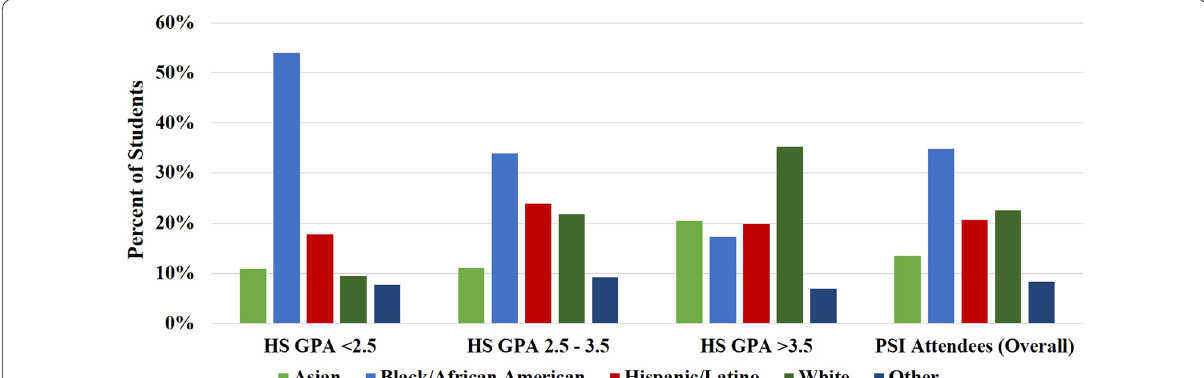
Fig. 7 Self‑identified racial/ethnic demographic distribution of students attending PSI sessions, separated by HS GPA, and compared to the self‑identified racial/ethnic demographic distribution of all PSI